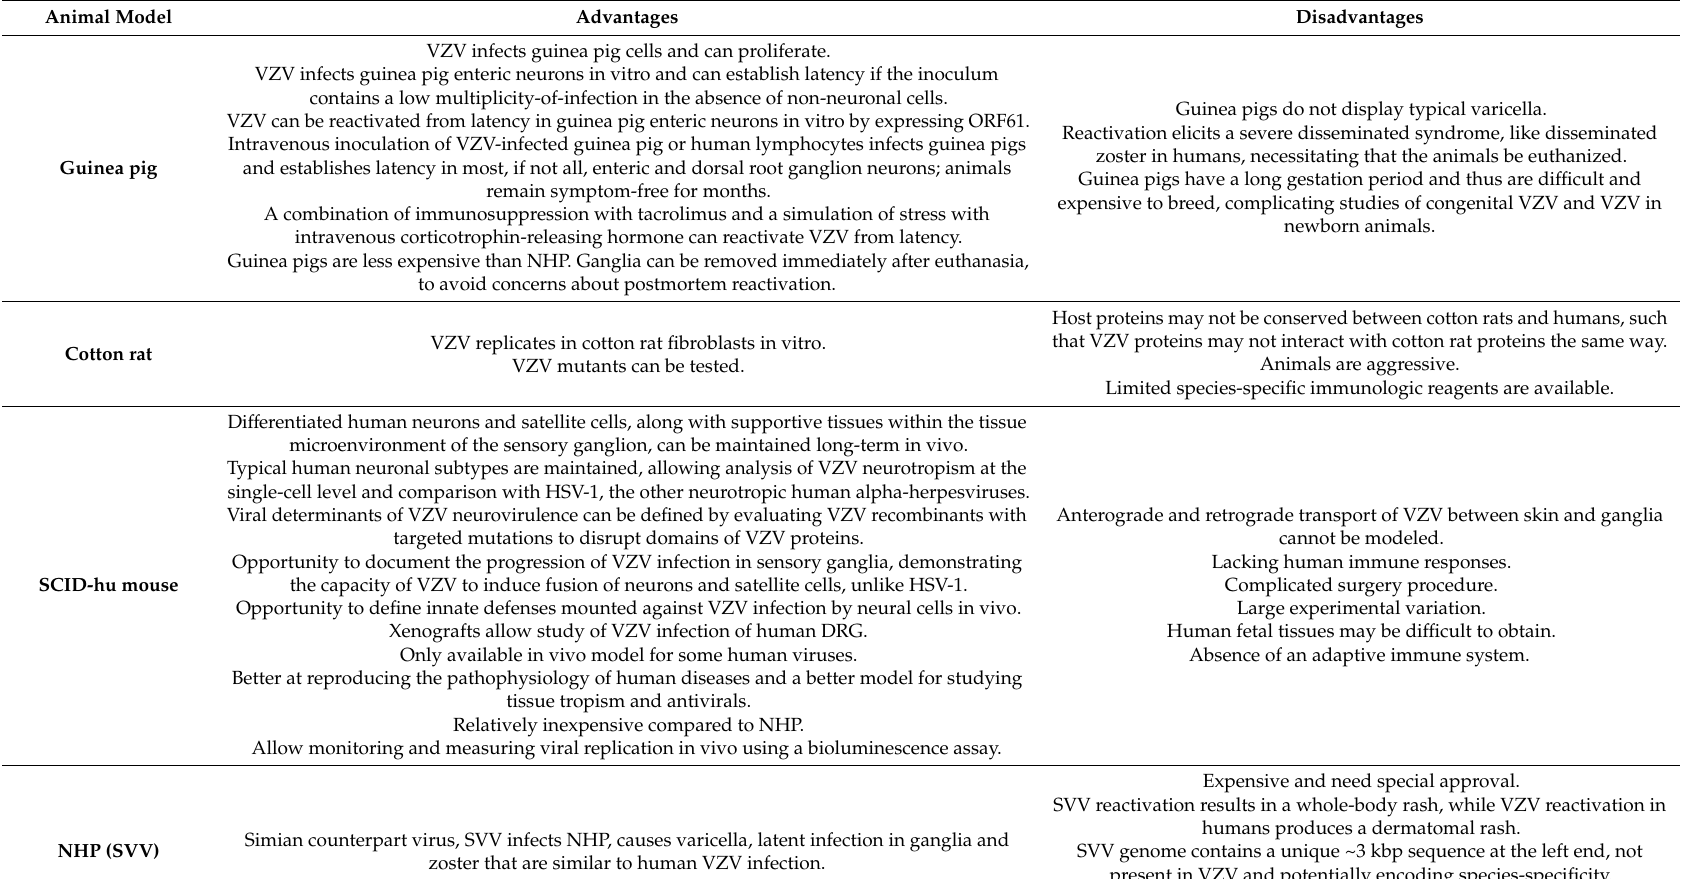
Table 1. Evaluation of animal models of VZV